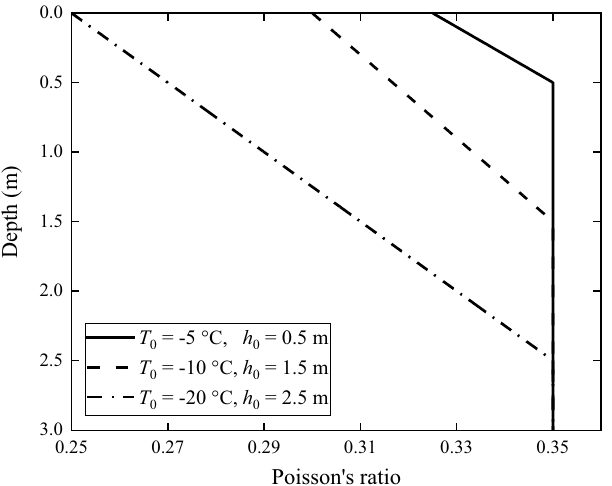
Figure 3. Poisson’s ratio of the frozen ground as function of depth.